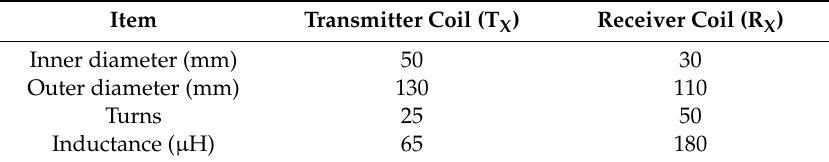
Table 3. Design results of the transmitter coil and receiver coil.